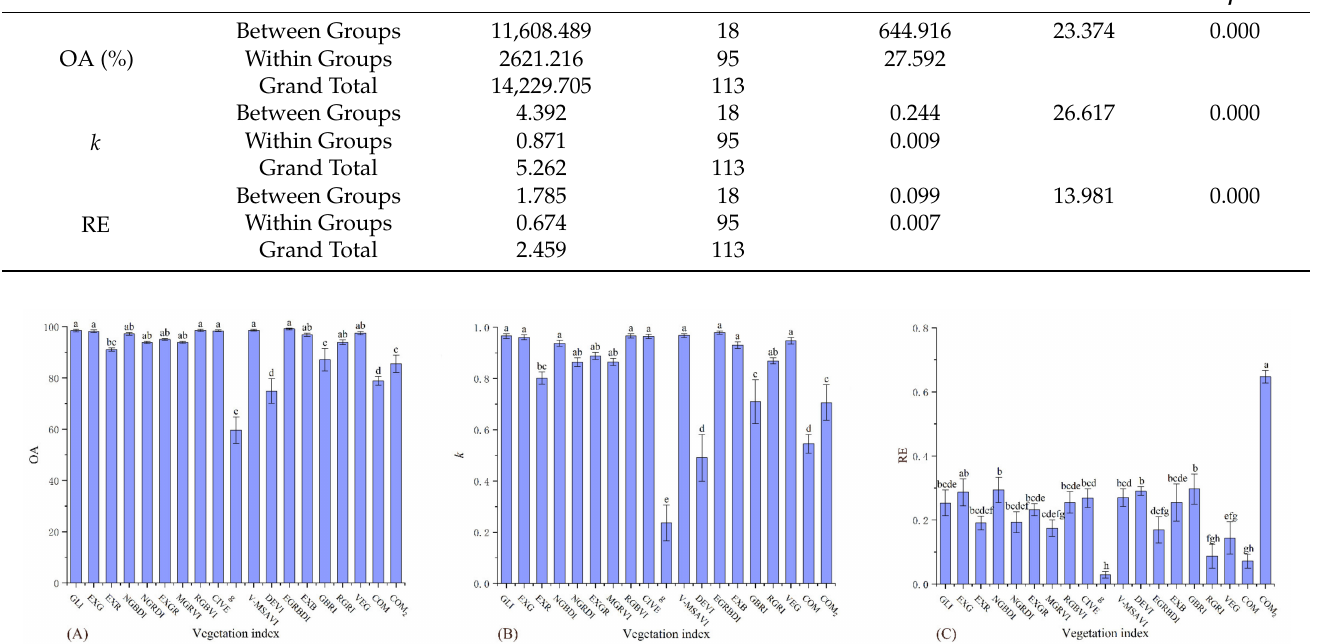
Figure 5. OA, k , and RE differences of 19 vegetation indices on the slight desertification grade. ( A ) figure is the result of one-way analysis of variance for OA. ( B ) figure is the result of one-way analysis of variance for k . ( C ) figure is the result of one-way analysis of variance for RE. Values with the same lowercase letters within vegetation indices are not significantly different at p <